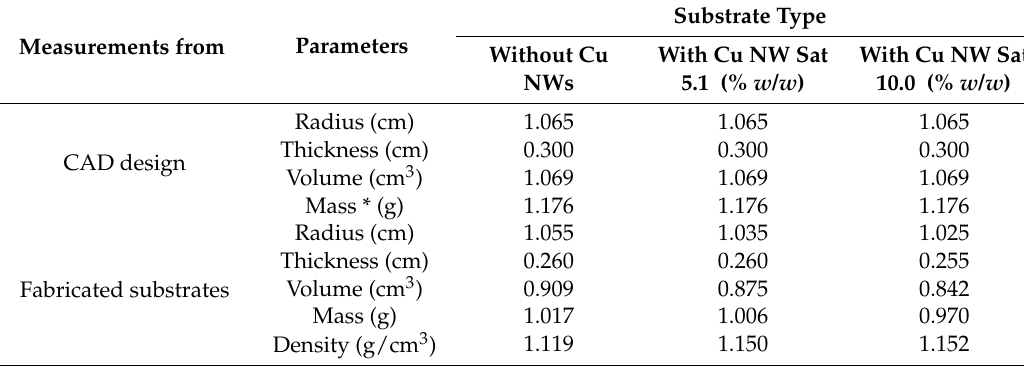
Table 2. Measurements of length, mass and volume of the cylindrical